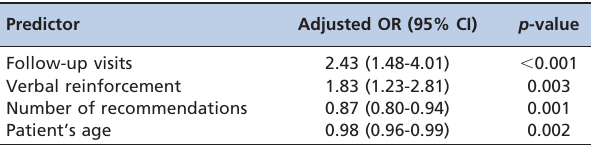
Table 3 - Independent predictors of adherence